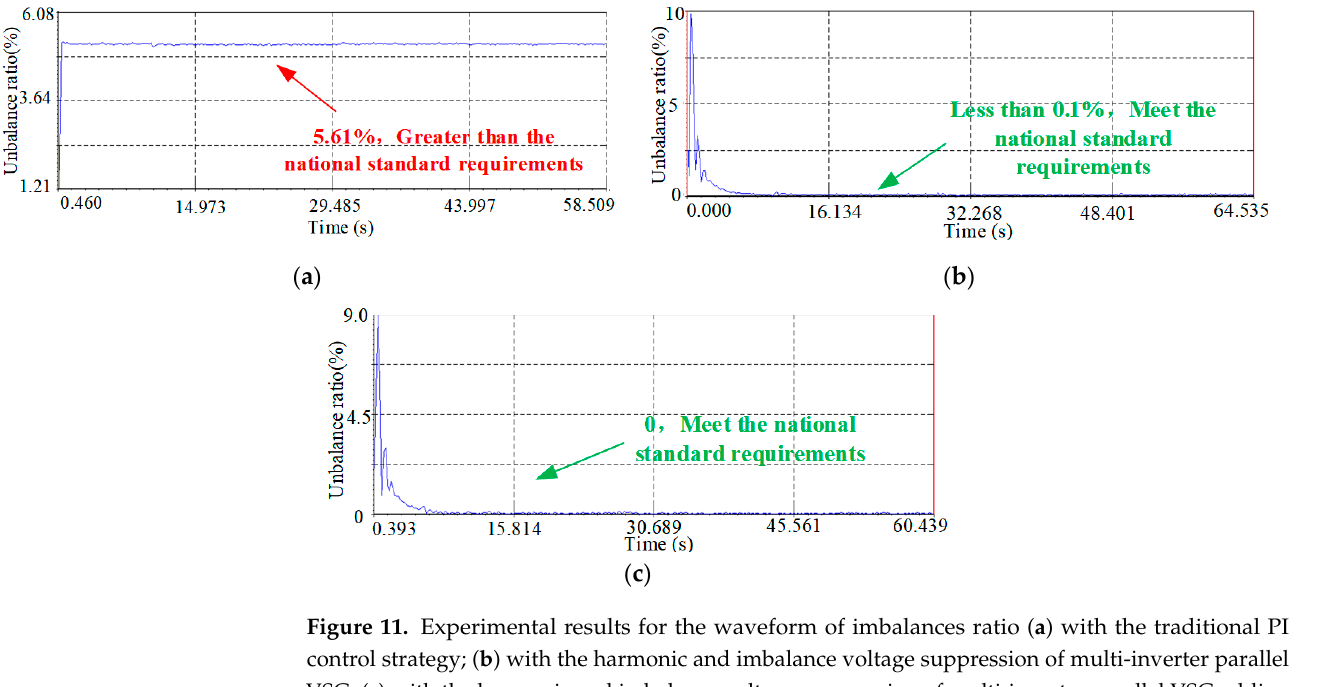
( c ) Figure 12. Experimental results for the FFT analysis harmonic waveform ( a ) with the traditional PI control strategy; ( b ) with the harmonic and imbalance voltage suppression of multi-inverter parallel VSG; ( c ) with the harmonic and imbalance voltage suppression of multi-inverter parallel VSG add- ing a secondary control strategy. As shown in Figure 13a, the experimental results for the voltage waveform of mi- crogrid for PCC point are distorted. In Figure 13b, the voltage waveform is obviously im- proved after adding the harmonic voltage suppression of the multi-inverter parallel VSG control strategy, which indicates the effectiveness of the proposed harmonic suppression strategy.